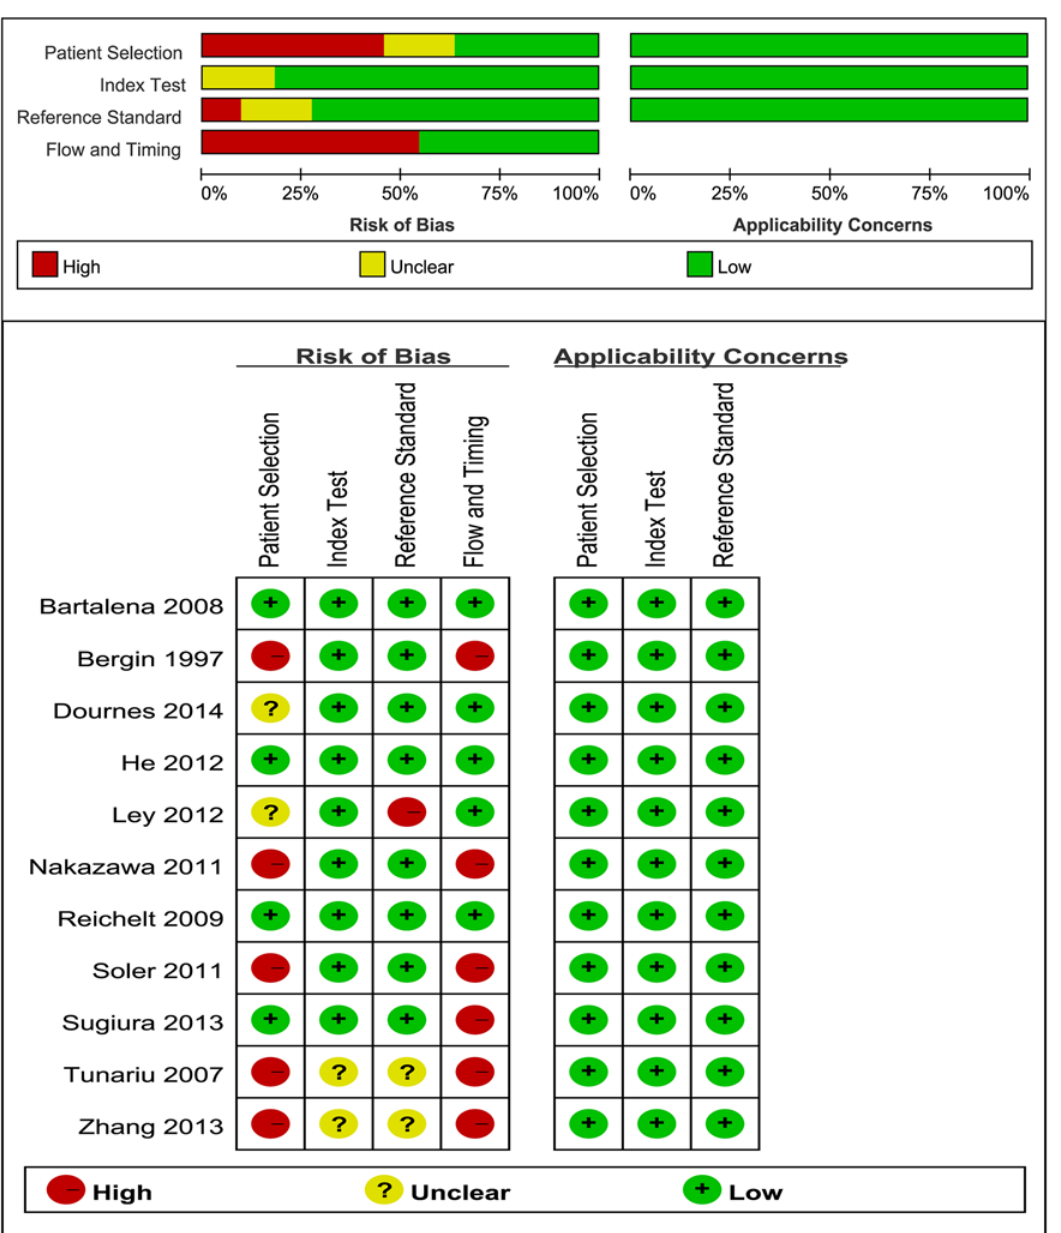
Fig 2. Pooled Quality Assessment of Primary